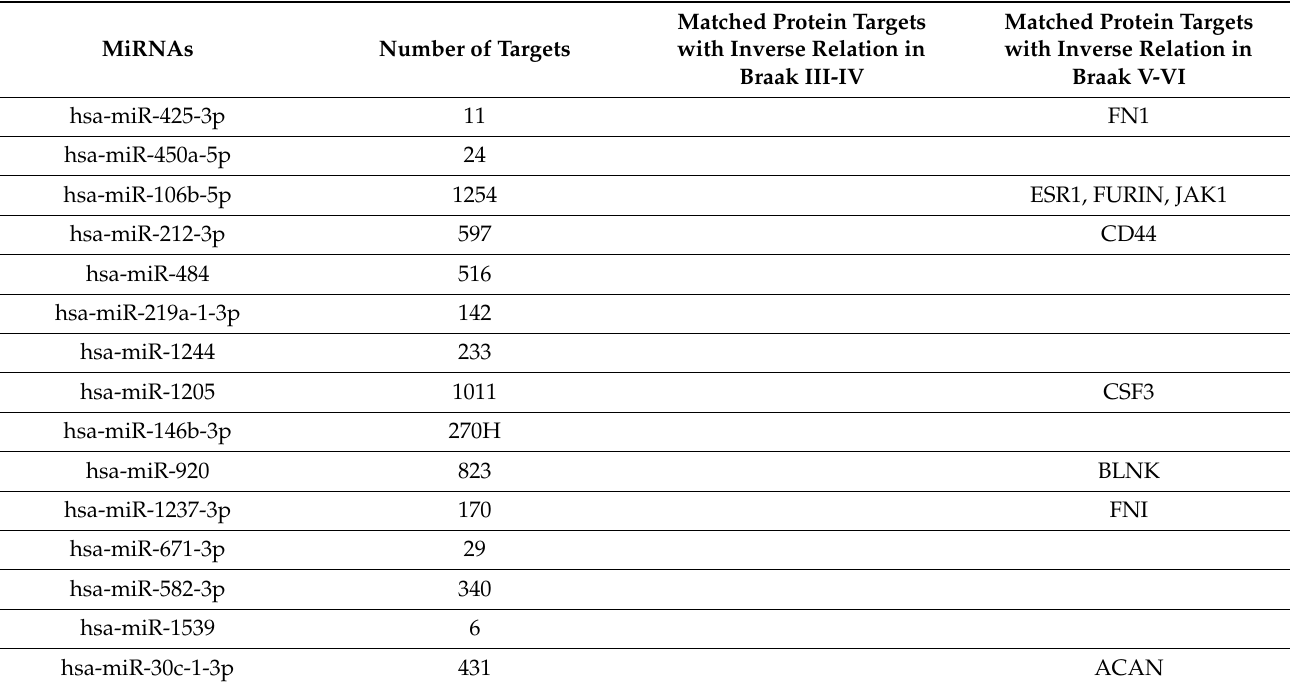
Figure 4. Braak stage V-VI pathways analyses.